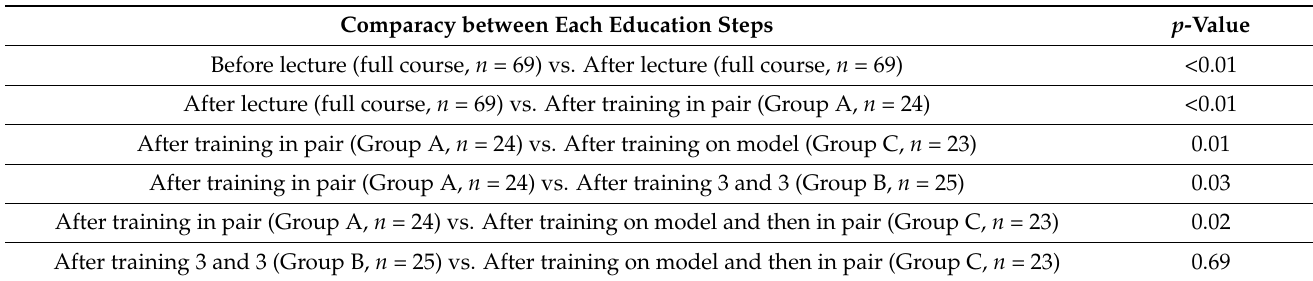
Table 1. Statistical comparison between each education step using the Mann–Whitney U-test. Comparacy between Each Education Steps p -Value